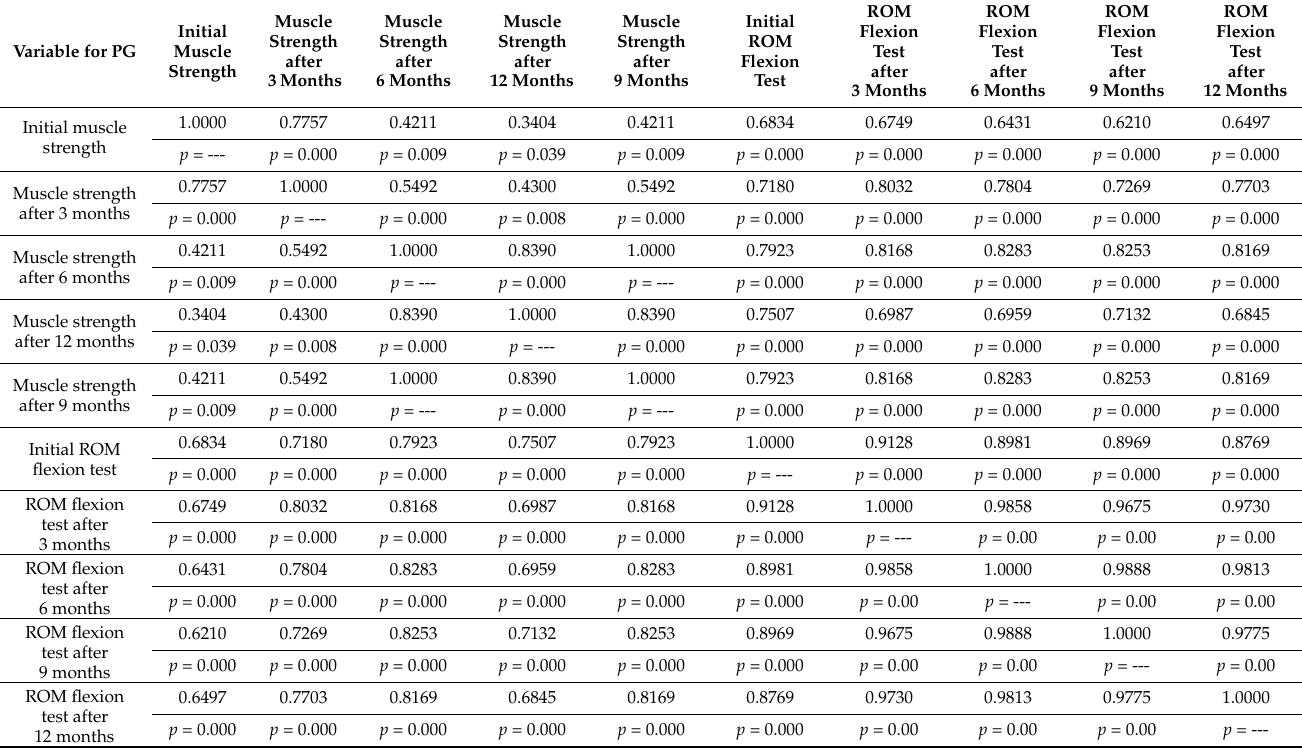
Table 4. Correlations between PG parameters of the